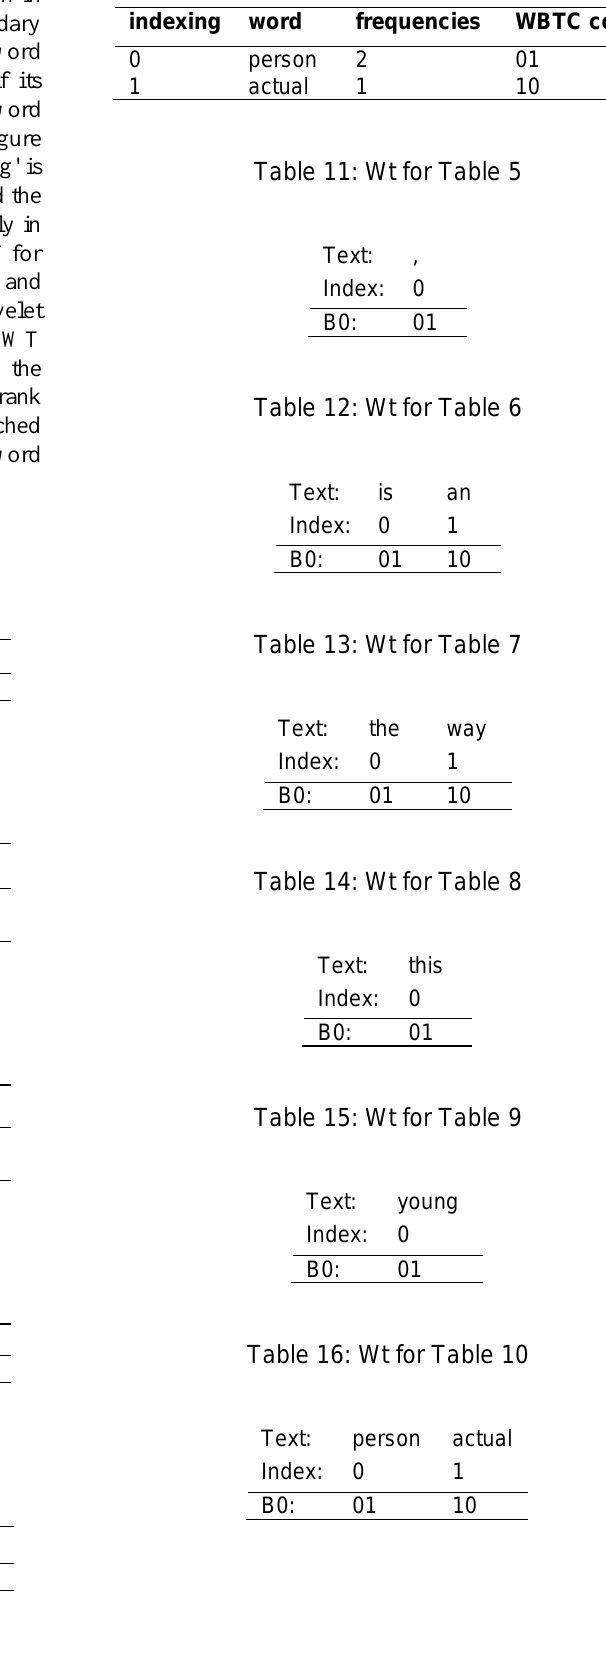
Table 10: Word-frequency table for length six